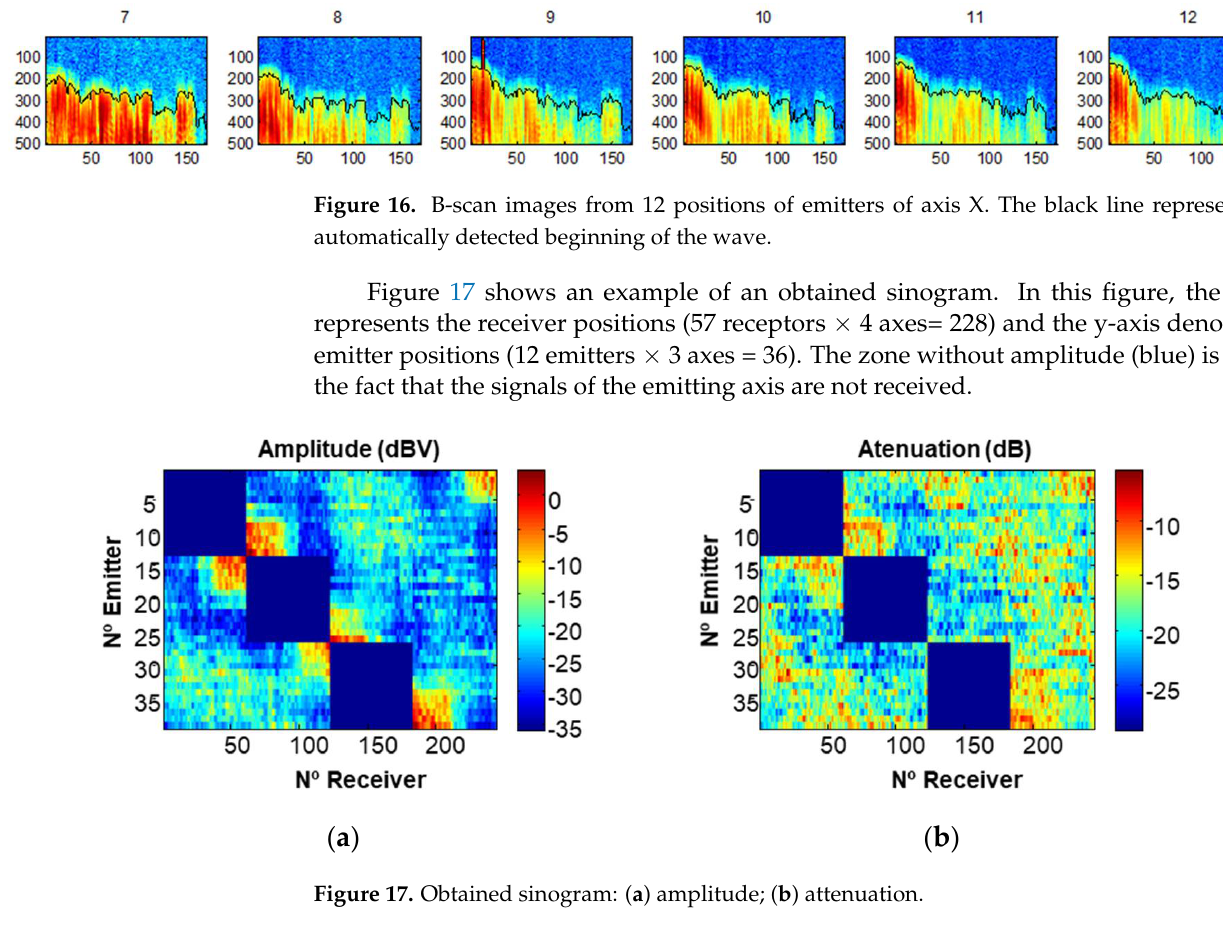
Figure 17. Obtained sinogram: ( a ) amplitude; ( b ) attenuation.